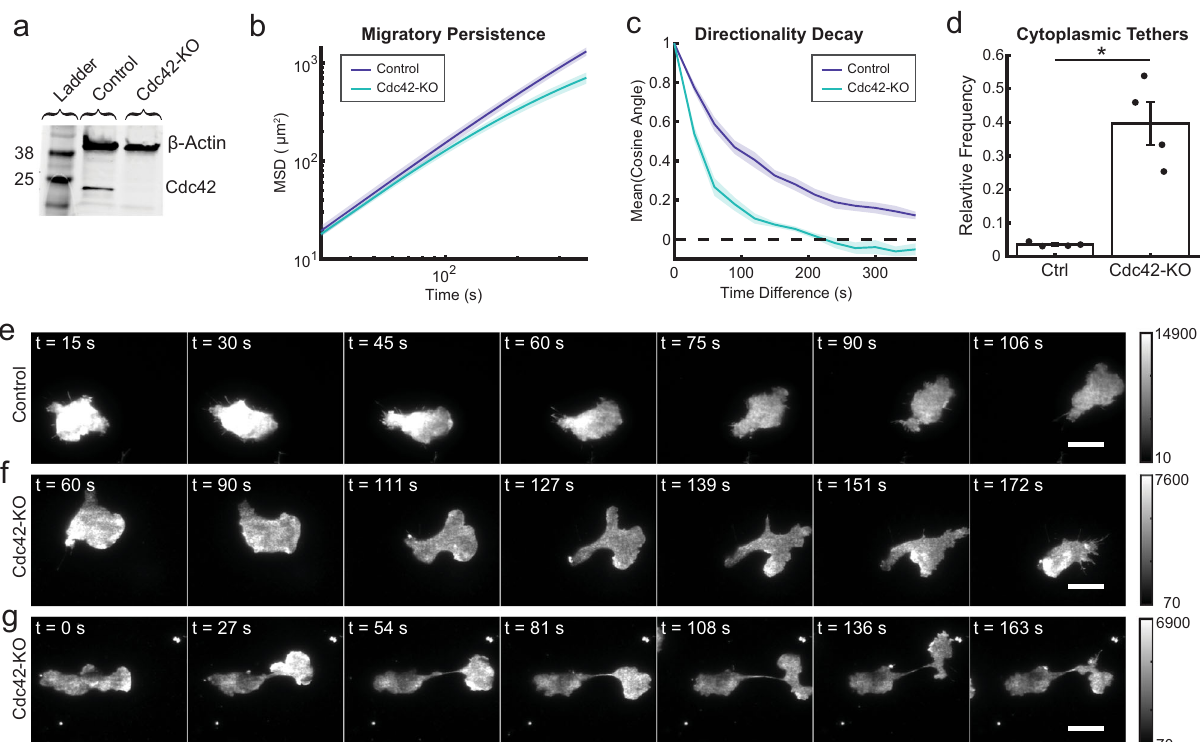
Fig. 4 Genetic knockout of CDC42 reveals a central role in organizing and maintaining cell polarity. a Western blot comparing the CDC42 -knockout (Cdc42-KO) and control cell lines stained for β -actin and Cdc42. Blot is representative of n = 3 experiments. b The mean-squared displacement (MSD) was measured as a function of time for control and Cdc42-KO cells randomly migrating. Data are presented as mean ± s.e.m. ( n experimen t = 4). A total of 10,687 control cells and 3018 Cdc42-KO cells were analyzed across the four experiments. c As a measure of directional persistence, the mean cosine of the angle between a migrating cell ’ s movement direction at two different time points was measured as a function of the difference in time between the two measurements. Cells migrating in a straight line would have a mean cosine angle of 1. Data are presented as mean ± s.e.m. ( n experimen t = 4). A total of 4821 control cells and 1098 Cdc42-KO cells were analyzed across the four experiments. d Fraction of cells exhibiting the cytoplasmic tether phenotype. Data are presented as mean ± s.e.m. ( n experiment = 4). A total of 331 control cells and 194 Cdc42-KO cells were analyzed across the four experiments. * P = 0.0108 using two-sided t test with unequal variances. Scattered points represent relative frequency for each experimental replicate. e Time-lapse image series of control cells randomly migrating. Control cells tend to maintain one cell front at a time and migrate more persistently. Scale bar, 15 µ m. Micrographs are representative of n = 331 cells. Grayscale bars indicate fl uorescence intensity. f , g Time-lapse image series of Cdc42-KO cells randomly migrating. Micrographs are representative of n = 194 cells. Scale bar, 15 µ m. Grayscale bars indicate fl uorescence intensity. f This cell displays a range of phenotypes, including a very large, crescent-shaped leading edge in the fi rst time point and multiple repolarization events thereafter. g This cell displays the cytoplasmic tether phenotype where the leading edge pulls away from the cell body, but remains linked by a thin cytoplasmic fi lament. Source data are provided as a Source Data fi le.